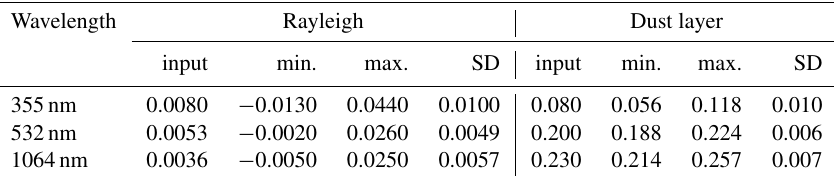
Table A2. The results of the simulation of the lidar system for the volume linear depolarization ratio. The simulation has been performed for the theoretical Rayleigh background and a typical value for the dust layer for each wavelength. The maximum and minimum value for each simulation and its standard deviation is